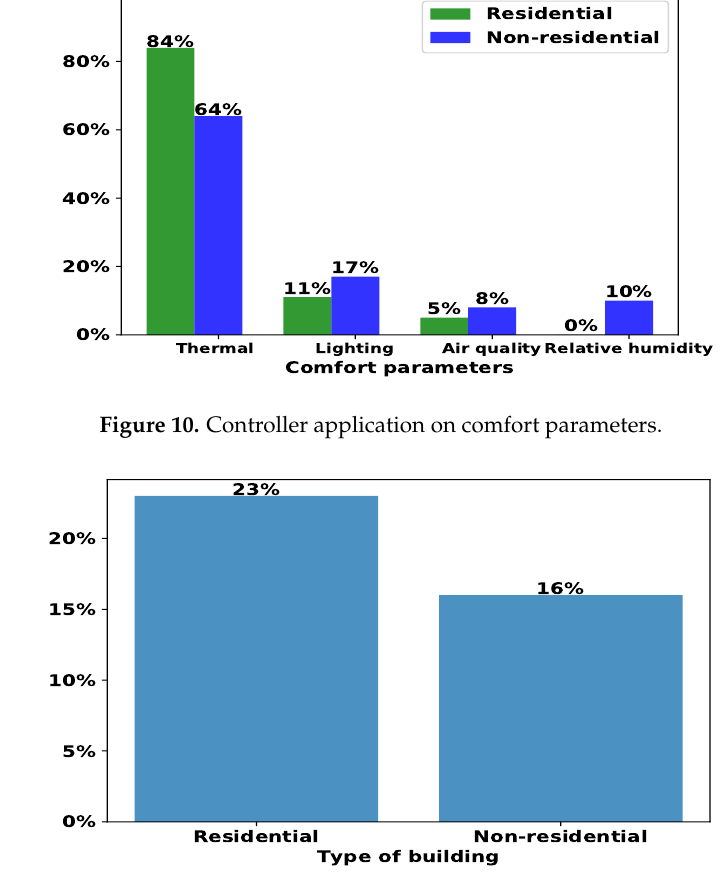
Figure 11. Renewable energy sources integration in both type of buildings.